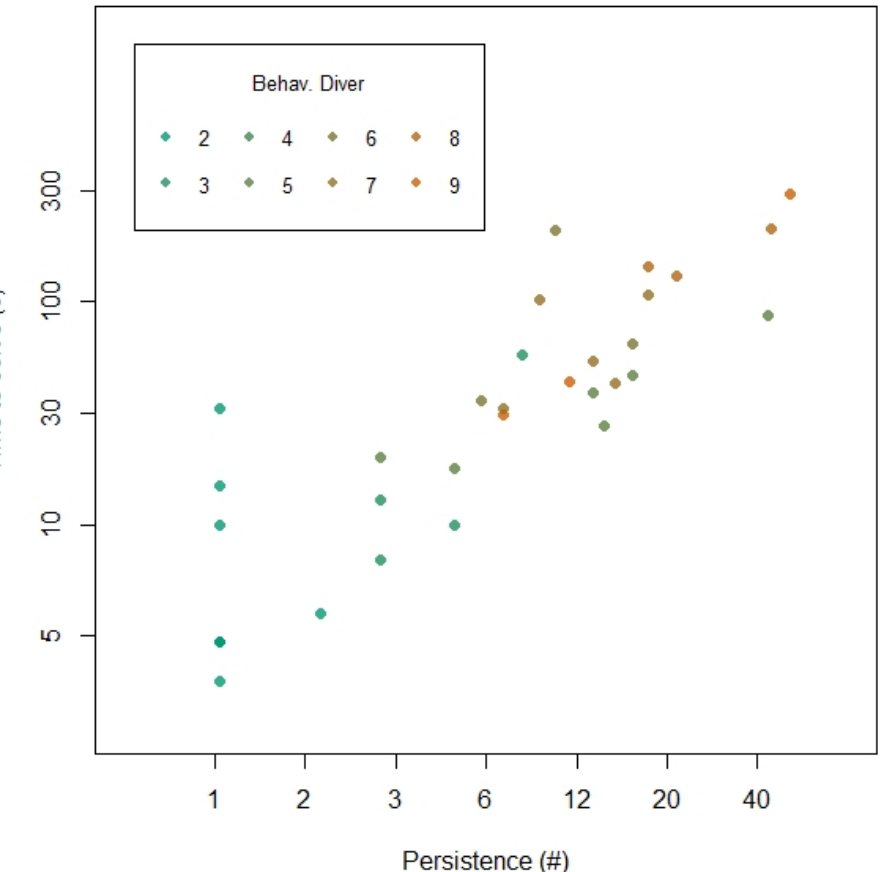
Note . Axes are in log 10 scale. As time-to-solve increases both the number of attempts and the types of attempts increases (greater behavioral diversity displayed in orange dots). Data points represent all trial values ( N = 32) from 14 individuals (mean number of trial values or data points per individual = 2.29, ±